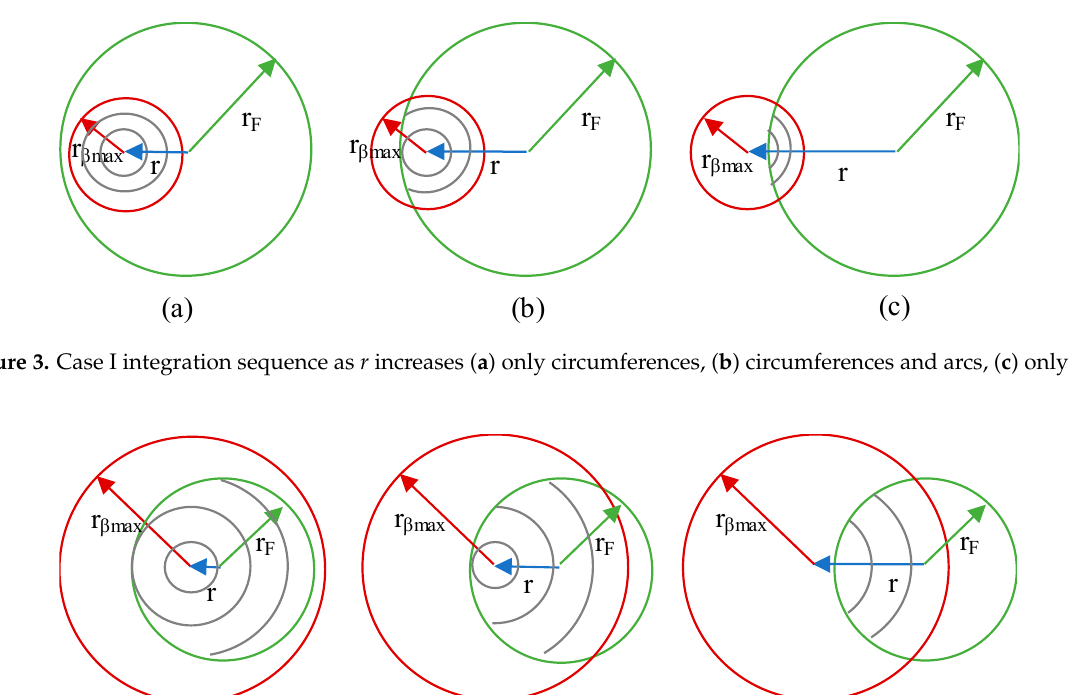
Figure 4. Case II integration sequence as r increases ( a ) circumferences and arcs, ( b ) circumferences and arcs with a different upper u limit, ( c ) only arcs.